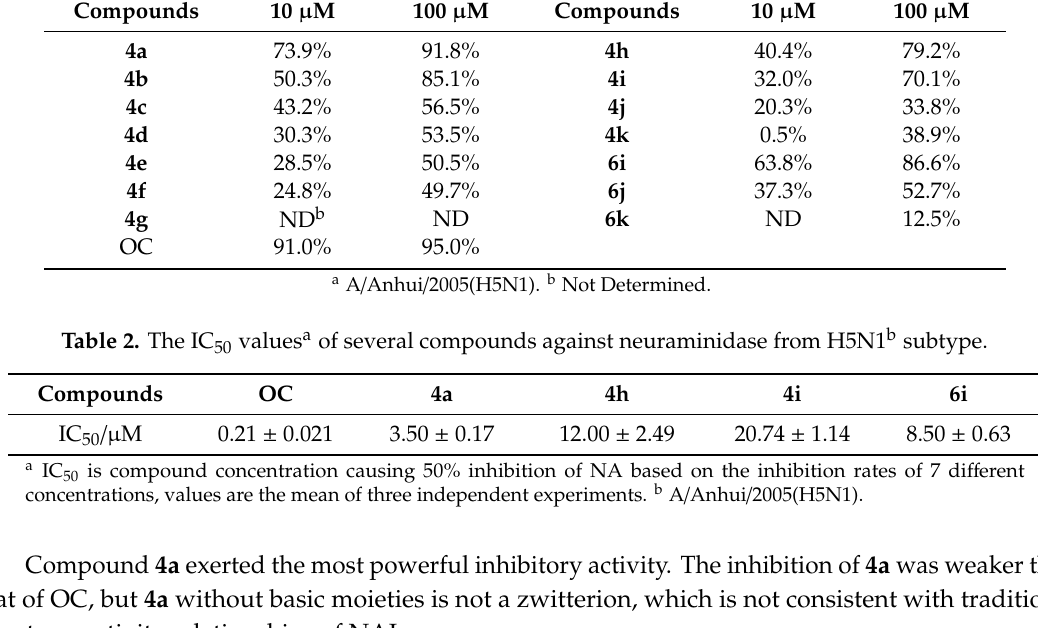
Table 1. The inhibition rates of synthesized compounds against NA from H5N1 a subtype. Compounds